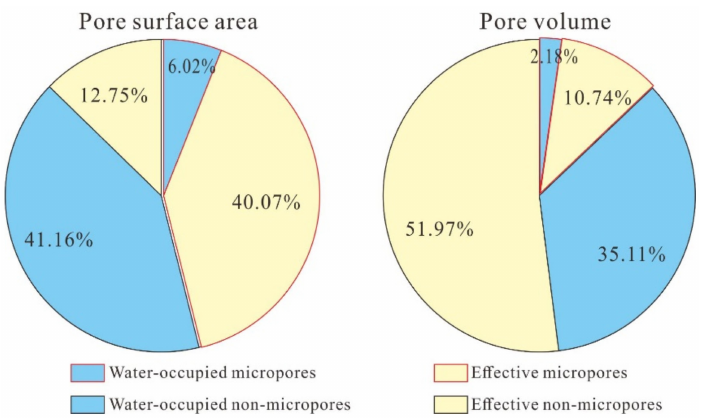
Figure 12. Average percentages of water-occupied and effective pore surfaces and volumes for the deep shales in the Luzhou